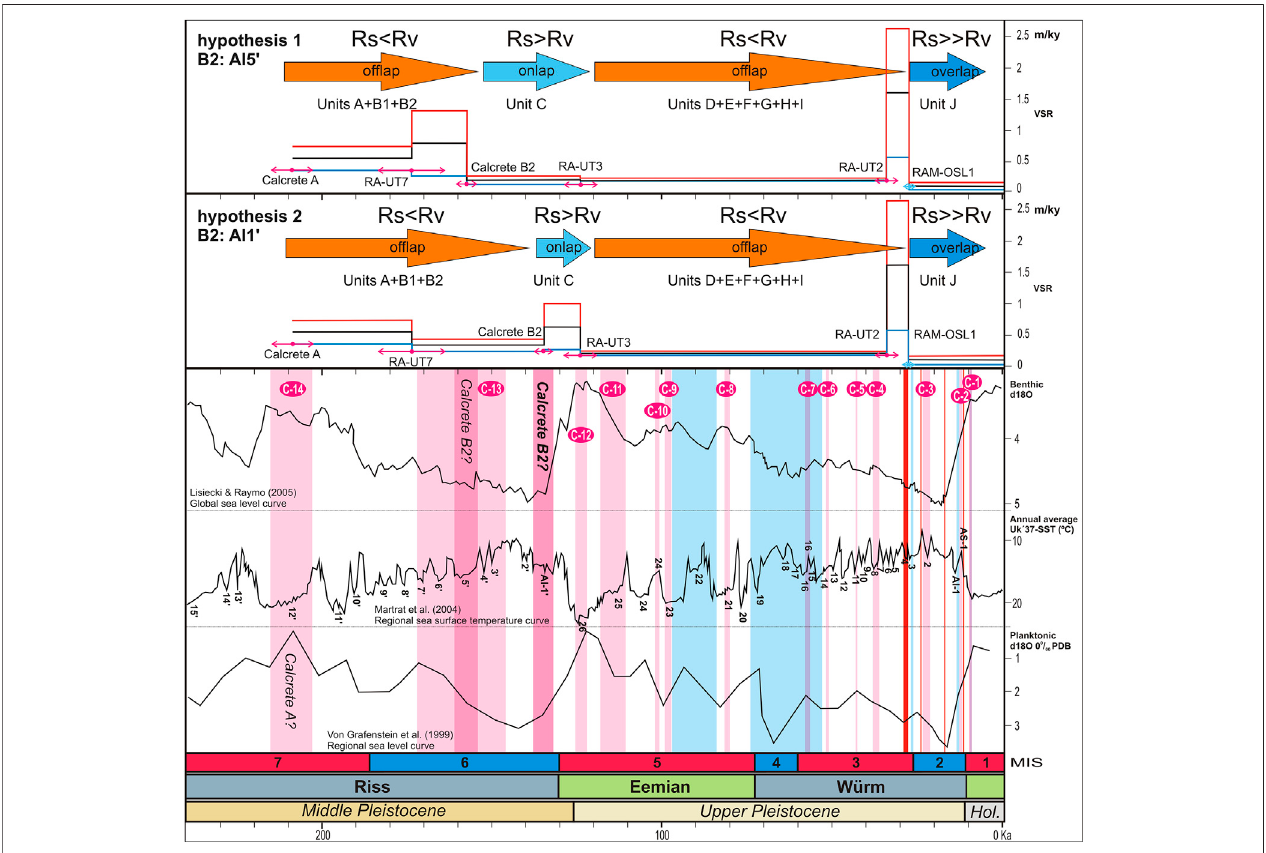
FIGURE 8 | Comparison of vertical slip rates (m/ky) (minimum values: blue line; mean values: black line; maximum values: red line) for the two hypotheses of the calcrete B2 age with the outcrop geometry (phase one: of fl ap (Rs < Rv), phase two: onlap (Rs > Rv), phase three: of fl ap (Rs < Rv) and phase four: overlap (Rs >> Rv), whereRs:sedimentation rateand Rv:verticalsliprate), thecalcreteformationperiods oftheSpainSE(pink stripes, C1-C14),depositionand paleosoilformationperiods around the Carrascoy Fault (blue and red stripes, respectively) and the paleoclimatic marine patterns.